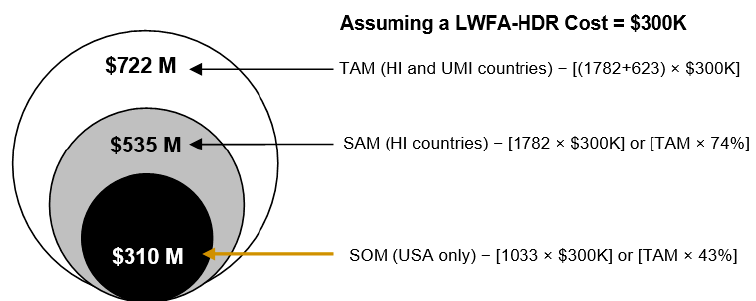
Figure 5. Estimated revenue from the LWFA-HDR brachytherapy system in HI & UMI, HI only, and US (based on Table 2 data) markets. Market size is depicted in terms of the total addressable